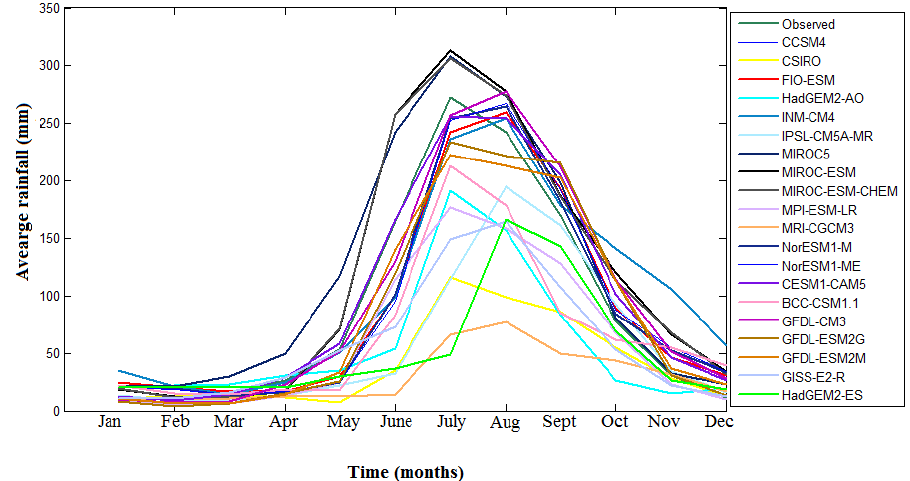
Figure 3. Average intensity of all-India observed and models over the time period 1871–2005.